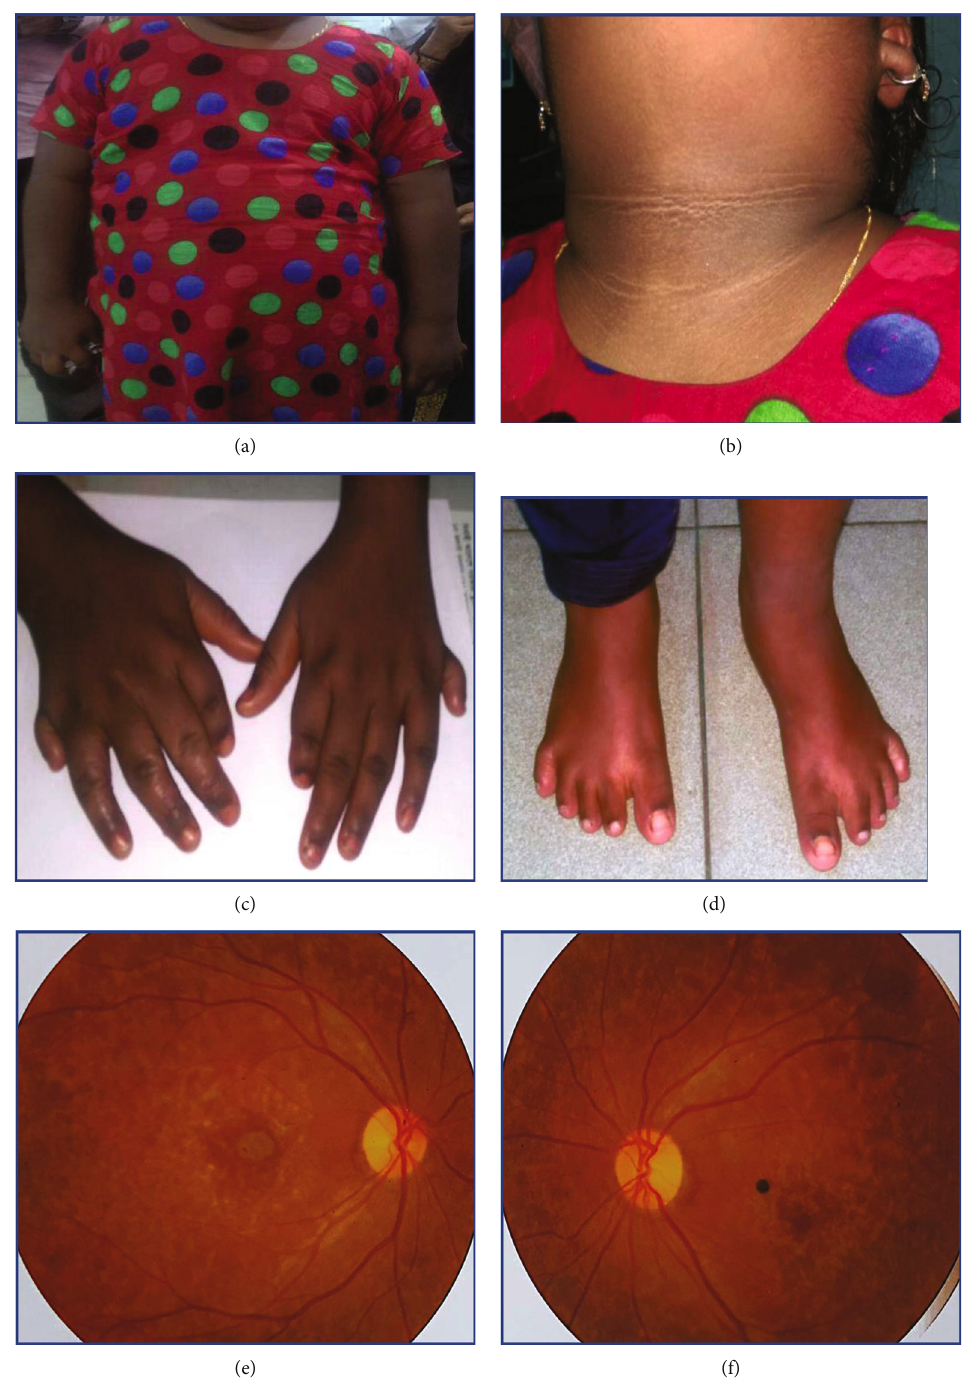
Figure 1: (a) Truncal obesity. (b) Acanthosis nigricans on the neck. (c) Bilateral upper limbs postaxial polydactyly. (d) Short, broad, and stubby fi ngers on the lower limbs. (e, f) Fundoscopic pictures of both eyes showing “ waxy ” optic disc pallor and pigmentary